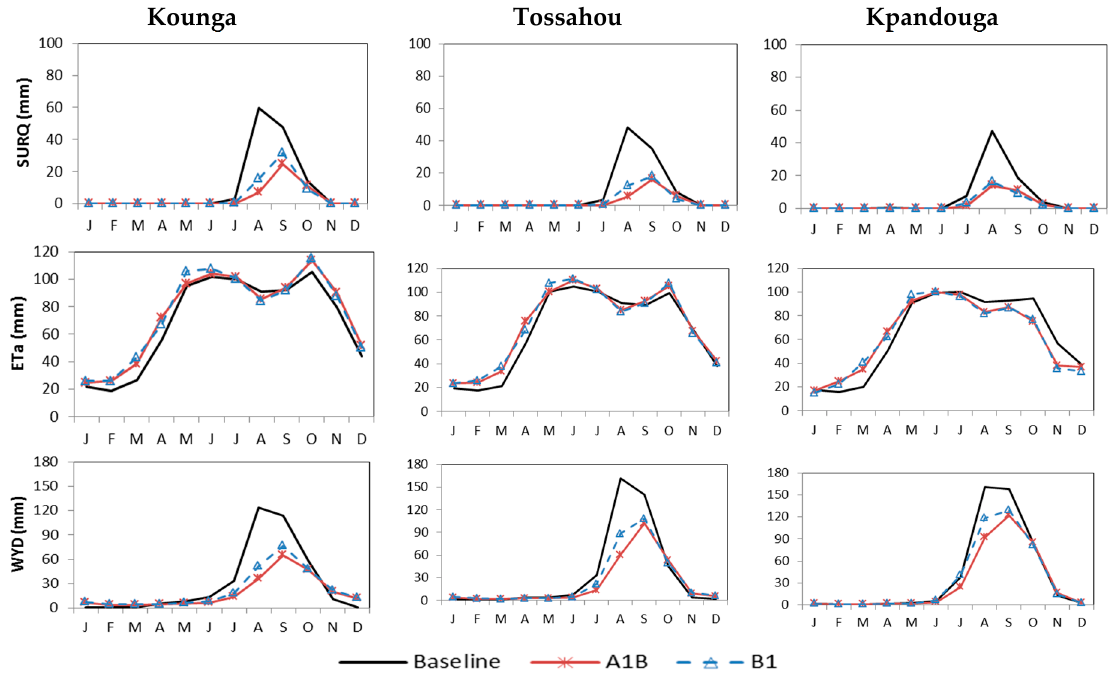
Figure 4. Comparison of monthly simulated water balance components between baseline period (1985–2003) and the projected period (2030–2049) under climate changes. A1B and B1 are climate change scenarios; ETa is actual evapotranspiration; SURQ is surface runoff; and WYD is total water yield.